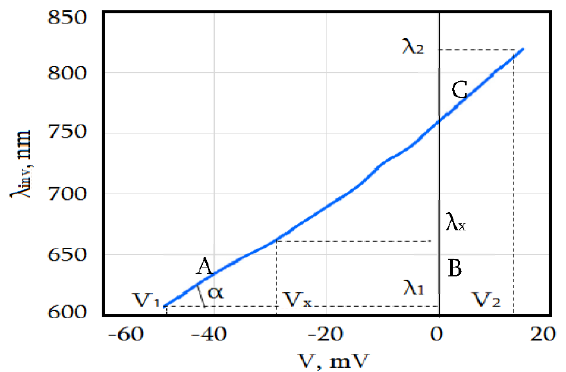
Figure 4. The dependence of the position of the inversion point of the spectral photocurrent on the photocurrent of the absorbed integral radiation.